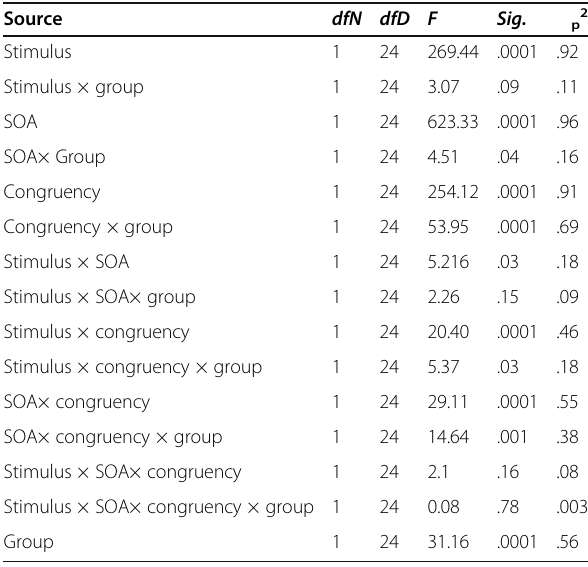
Table 2 The result of mixed-ANOVA tests between the sham and experimental groups in the post-test